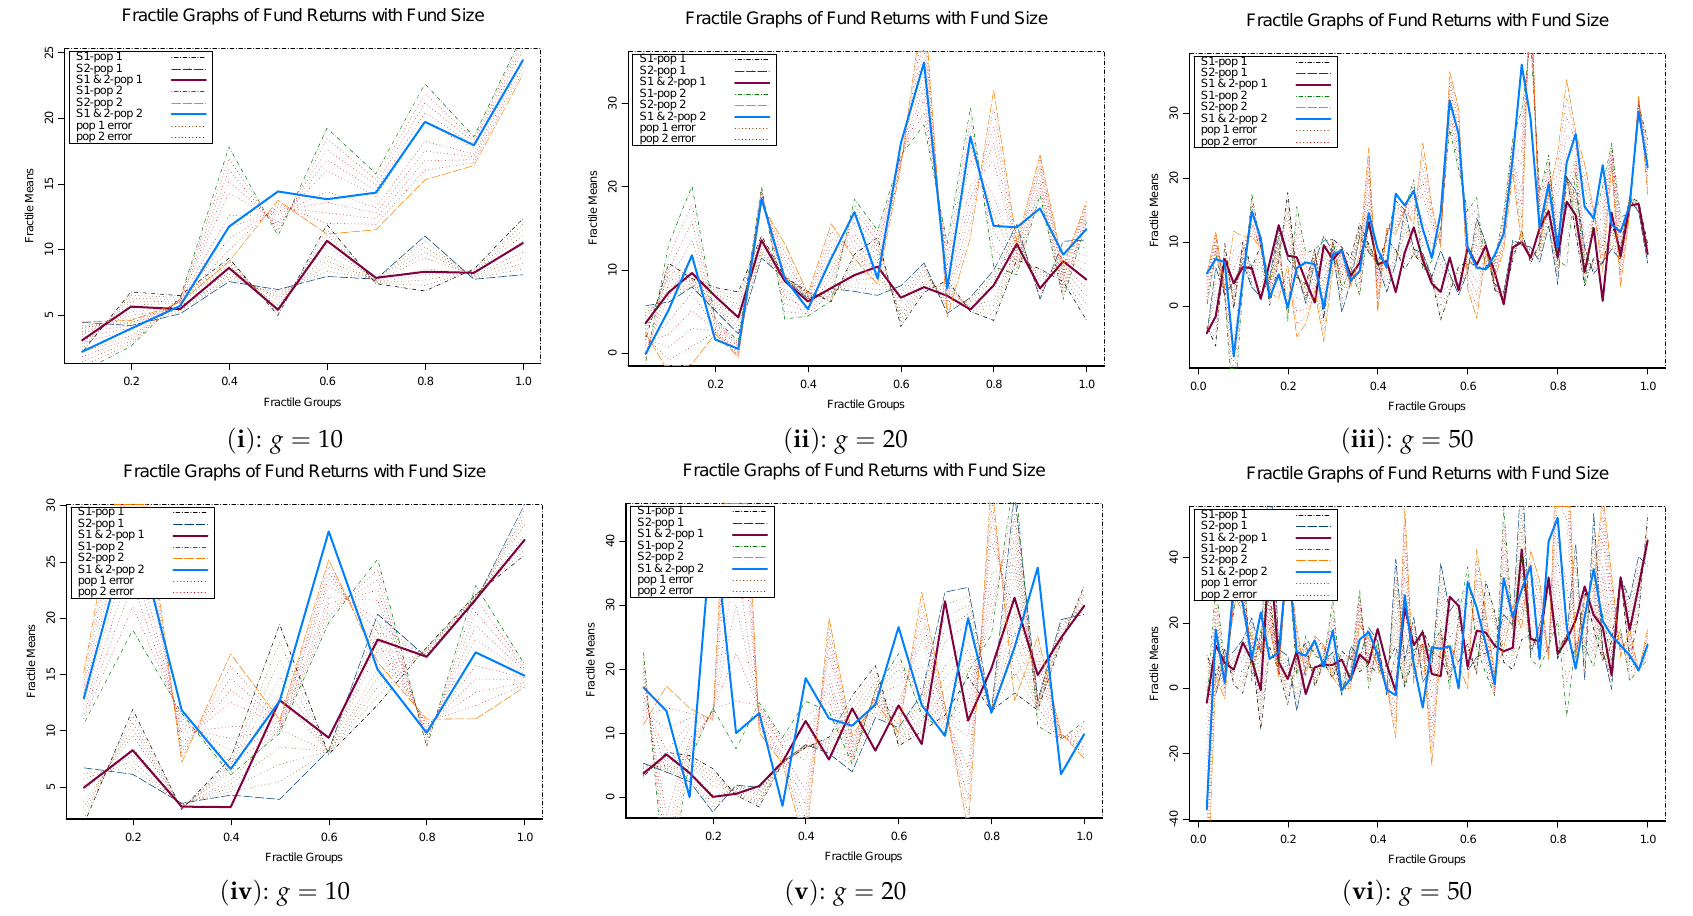
Figure 3 ( iv ) : g = 10 Figure 3 ( v ) : g = 20 Figure 3 ( vi ) : g = 50 Figure 3. Fractile graphs (Mahalanobis 1961) for different number fractile groups ( g ) for public and private equity ( i – iii ) and between venture capital (VC)